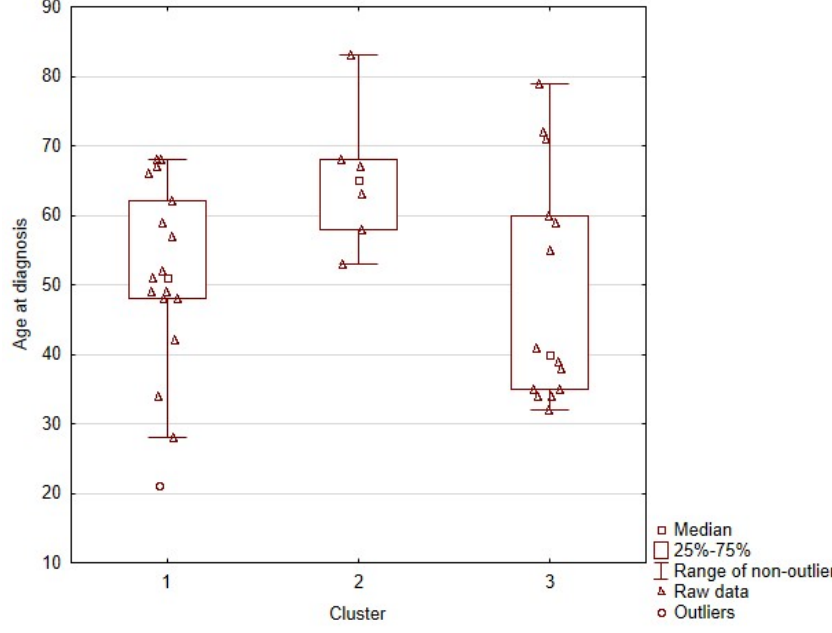
Figure 2. Graphic representation of age distributions in the obtained clusters. The three clusters did not differ in the stage of the disease at diagnosis of the patients (staging I, II, IIIA/C; according to AJCC, 8th ed. [18]), p = 0.7917. The patients did not differ in the frequency of lymph node metastases ( p = 0.6601), nor in the frequency of distant metastases ( p = 0.2714).